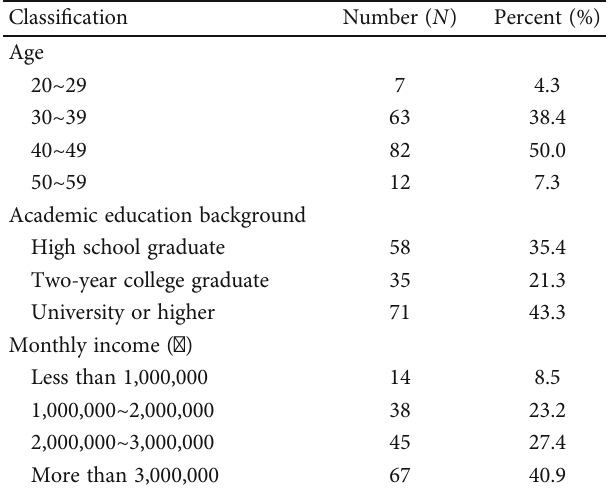
Table 1: General characteristics of mothers of children with disability ( N = 164 ).